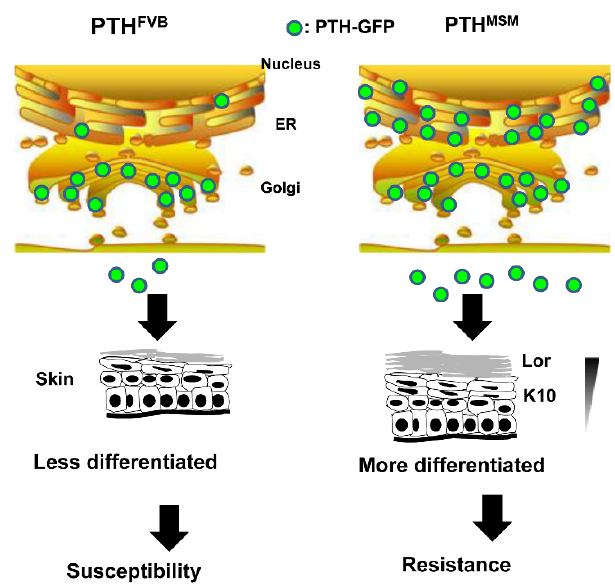
Figure 2. Mechanism of action of PTH in skin tumor resistance. The coding SNP in the Pro-PTH encoding region markedly enhanced the processing and increased secretion of PTH in MSM/Ms. Higher PTH levels elevated calcium levels in keratinocytes, which promoted their differentiation and ultimately led to resistance to skin tumorigenesis. ER denotes Endoplasmic Reticulum. K10 denotes Keratin 10. Lor denotes Loricrin.